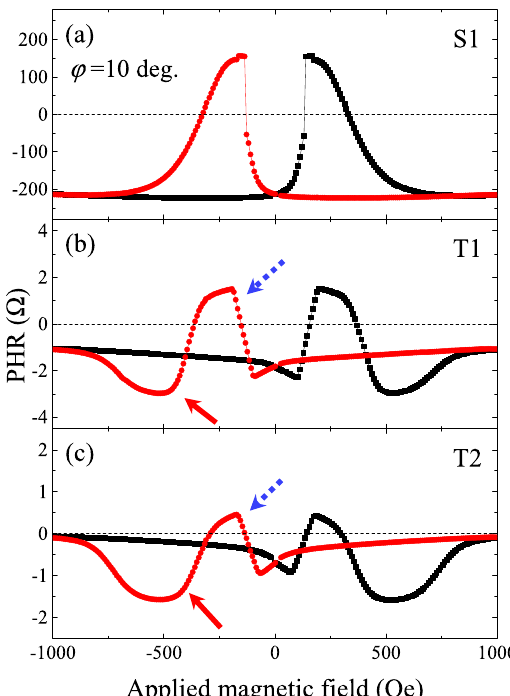
Figure 2. Planar Hall resistance obtained from three samples at 3 K at field orientation ϕ = ° 10 plotted in panels ( a ), ( b ), and ( c ) are obtained from samples S1, T1, and T2, respectively. Red and black symbols represent data obtained for down and up sweep of fields, respectively. Blue (dotted) and red (solid) arrows indicate downward and upward jumps showing hysteretic behavior, as discussed in the